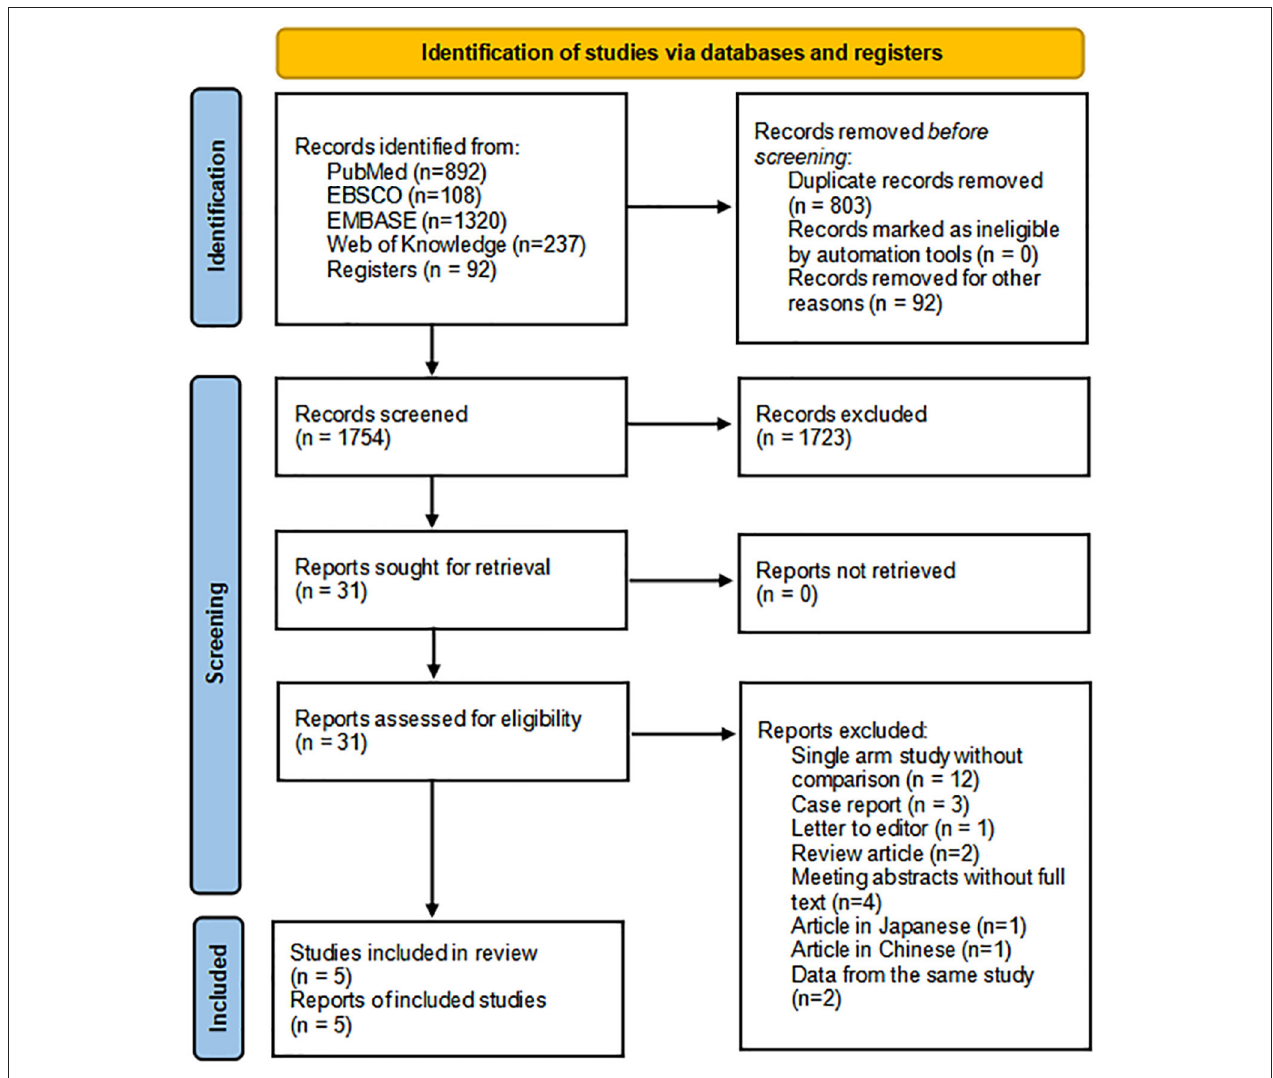
FIGURE 1 | PRISMA flow diagram for study